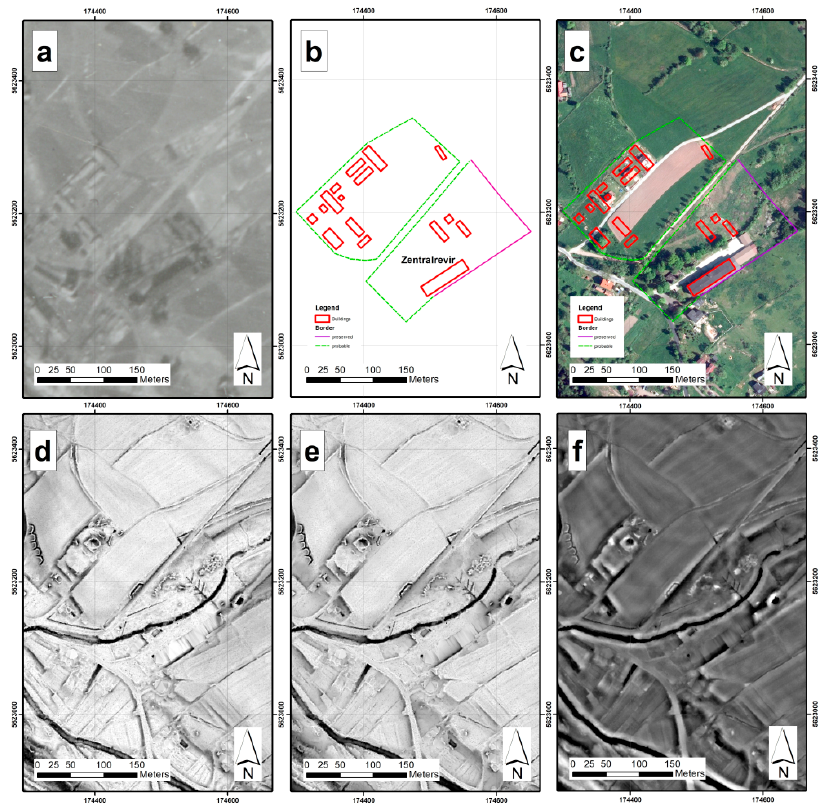
Figure 9. Labour Camp AL Dörnhau: ( a ) ’45 aerial photo (© NARA), ( b ) reconstruction of camp based on ’45 photo, ( c ) recent orthophoto of camp area with outlined camp plan (© Head Office of Geodesy and Cartography in Poland), ( d ) SVF image (radius 5 m), ( e ) Openness positive image (radius 10 m), ( f ) Local Dominance image (min. / max.: 10 m – 10 m). Coordinate grid: UTM Zone 34 N (EPSG: